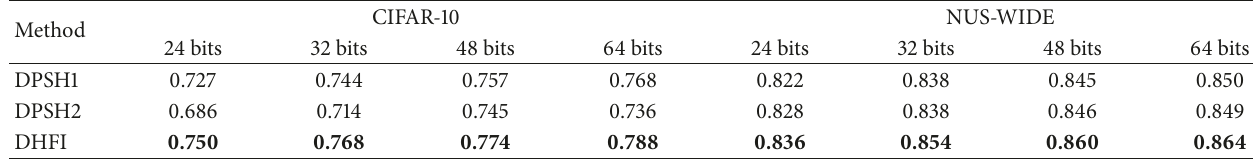
Table 1: Accuracy in terms of MAP compared to two different deep DPSH